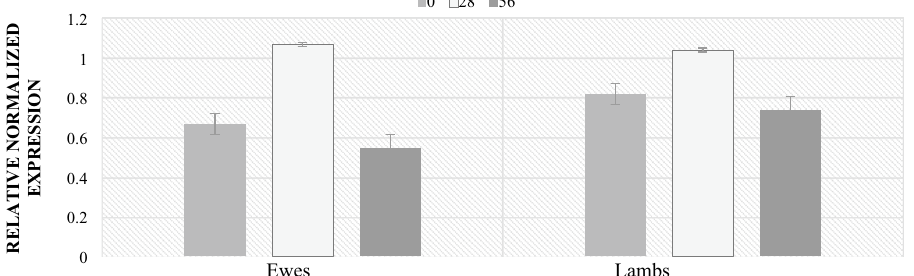
Figure 8. Level of Lactobacillaceae (RNE) in ewes and lamb feces.